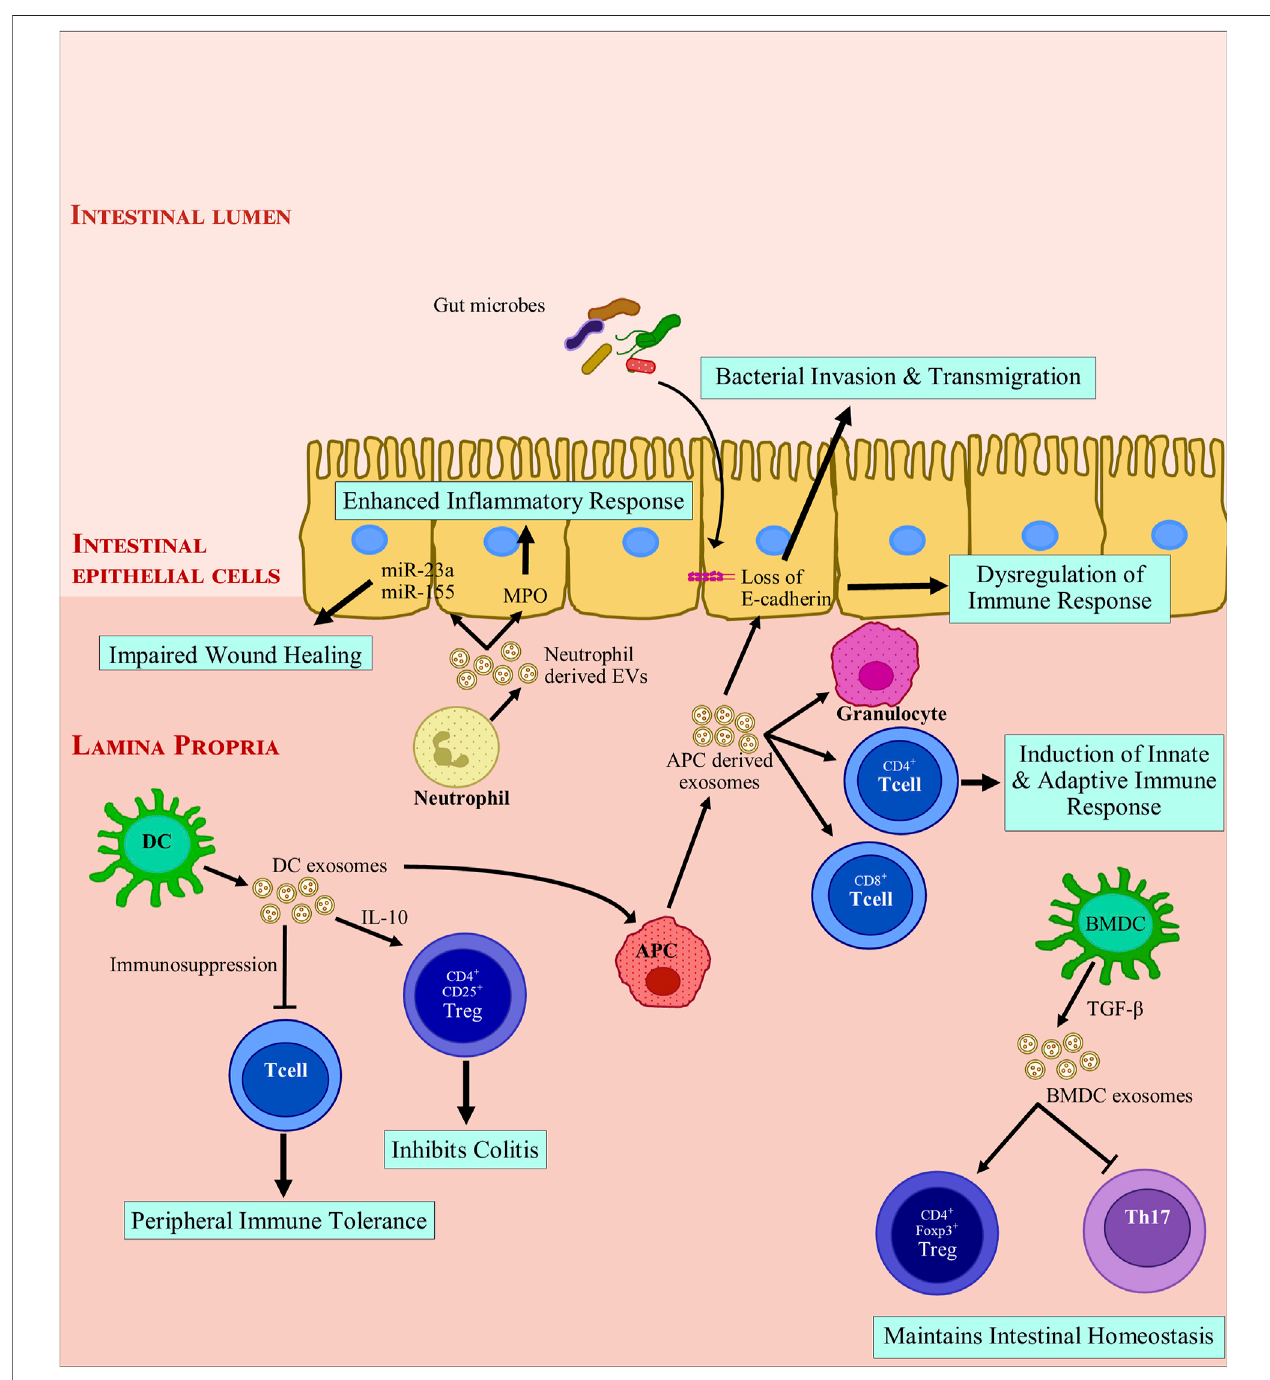
FIGURE 2 | Modulation of intestinal in fl ammation by immune cell derived extracellular vesicles. Exosomes derived from immune cells promote anti-in fl ammatory responses by inducing immune tolerance and triggering regulatory T cells (Treg) activation while inhibiting T helper cells. Exosome-treated immune cells further express exosomes that encourage anti-in fl ammatory responses. Mature APC derived exosomes promote loss of E-cadherin, which leads to breach of barrier integrity and facilitates bacterial invasion and transmigration. These exosomes also recruit immune cells and drive a pro-in fl ammatory immune response. Neutrophil derived exosomes secrete myeloperoxidase and miRNAs which are taken up by intestinal epithelial cells. miR-23a and miR-155 can introduce double strand breaks and impair woundhealingindegeneratedcolonicepithelium.Insummary,dependingontheparentcells,exosomesderivedfromimmunecellscandrivetowardapro-in fl ammatory or an anti-in fl ammatory response. APC, antigen presenting cell; BMDC, Bone marrow derived dendritic cell; CD, cluster of differentiation; DC, dendritic cell; EV, extracellular vesicles; FOXP3, Forkhead box protein 3; IL-10, Interleukin 10; miR, microRNA; MPO: myeloperoxidase; TGF- β , transforming growth factor β ; Th17, T helper 17; Treg, regulatory T